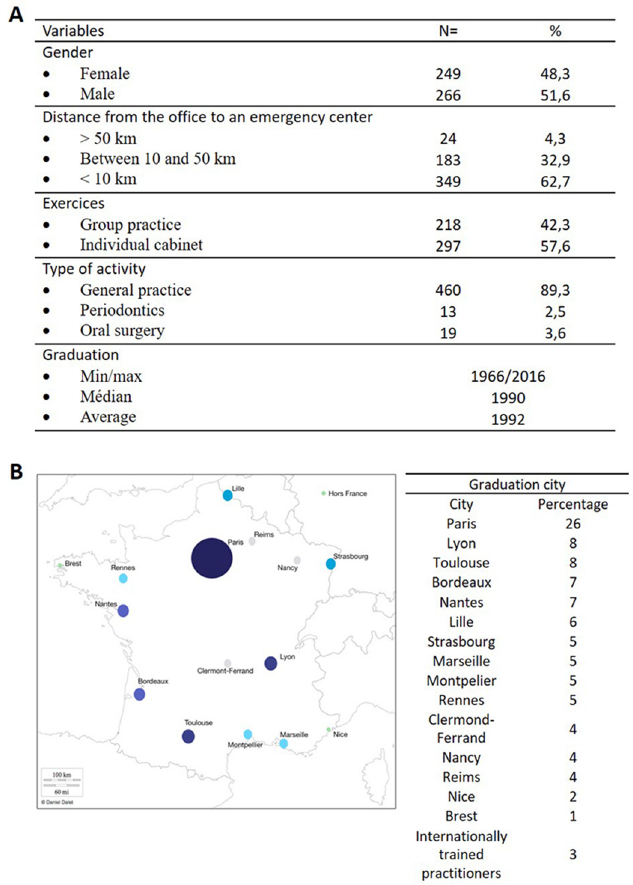
Fig. 1. Study sample demographic data. (A) Study sample character- istics; (B) Geographic repartition based on graduation